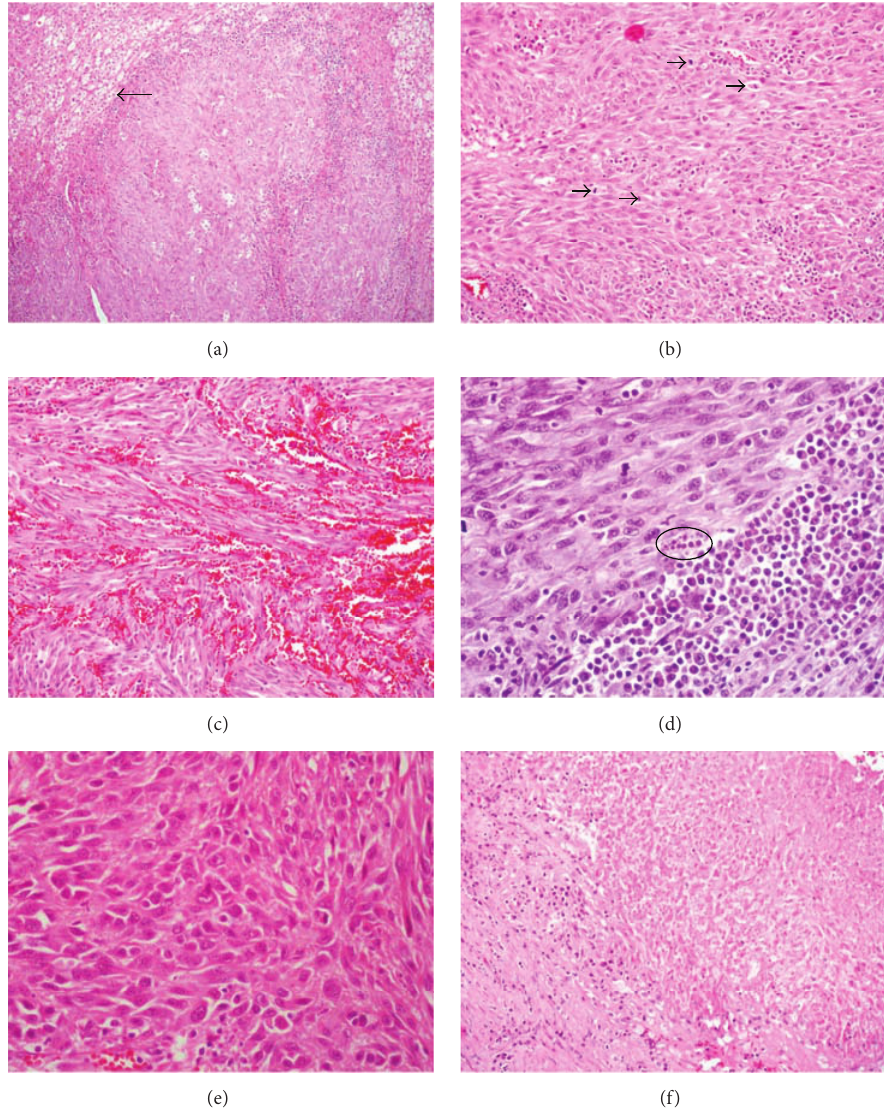
Figure 2: (a) Normal adrenal cortex parenchyma (arrow) invaded by tumor (hematoxylin-eosin × 40). (b) Tumor composed of short fascicles and storiform patterns of spindle or epithelioid cells with oval-round nuclei and eosinophilic fibrillary cytoplasm. Increased mitosis is also seen (arrows) (hematoxylin-eosin × 100). (c) Slit-like spaces and extravasated red blood cells within the tumor cells (hematoxylin-eosin × 200). (d) PAS positive intracytoplasmic hyaline globules in some tumor cells (circle) ( × 400). (e) Epithelioid tumor cells with nuclear atypia